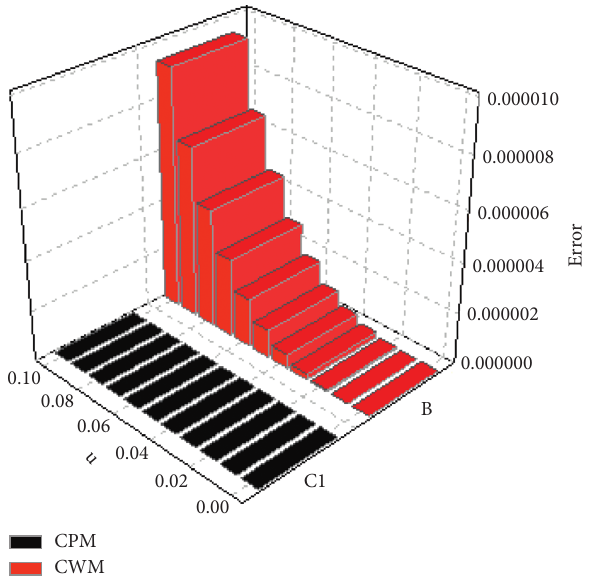
Figure 12: Error graph of CWM and CPM for problem